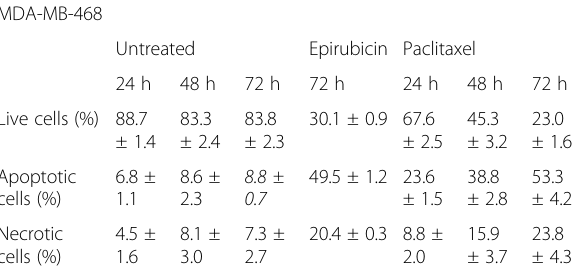
Table 2 Apoptosis analysis of MDA-MB-231(a) and MDA-MB- 468(b) cells after incubation with treatment at 10xIC 50 for 24 h, 48 h, and 72 h by flow cytometry using Annexin V/PI apoptosis assay. Results are shown as mean ± SD ( n = 3 independent experiments)